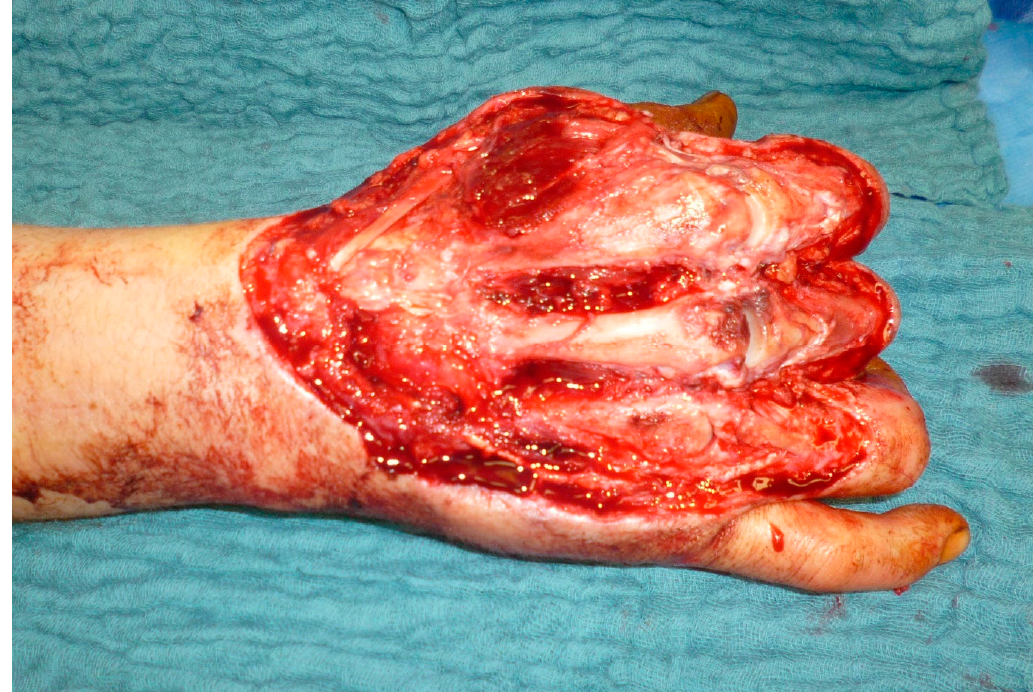
Figure 7. Defect after burn wound debridement of a full-thickness burn to the hand. Necrotic extensor tendons and necrotic capsules of metacarpal joints were resected.